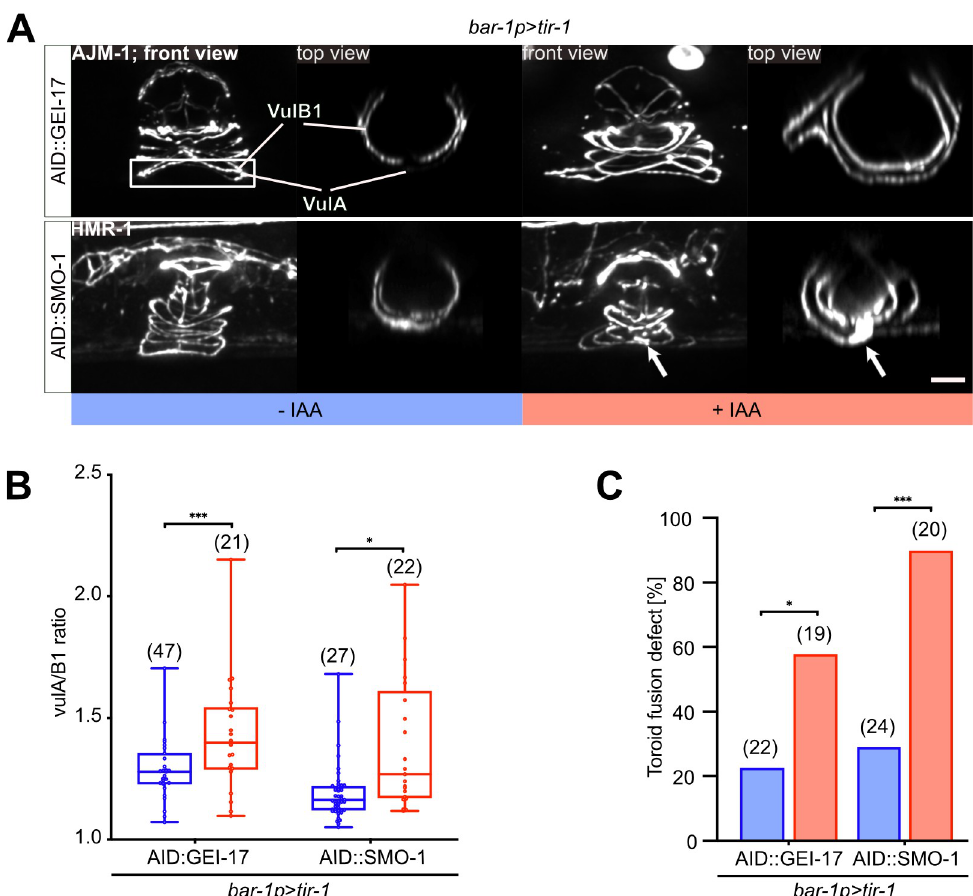
Fig 4. Inhibition of the SUMO pathway in the VPCs causes toroid morphogenesis defects. (A) Toroid morphogenesis defects in L4 hermaphrodites. 3D reconstructions of the adherens junctions labelled with AJM-1::GFP (for AID::GEI-17) or HMR-1::GFP (for AID::SMO-1) after VPC-specific degradation. Left panels show lateral views of z-projections. vulA and vulB1 toroids are outlined by the white rectangle in the top left panel and shown in top (xz) views in the right panels. White arrows point to abnormal fusion between the vulA and vulB1 toroids after AID::SMO-1 degradation. (B) Quantification of vulA contraction, calculated as the ratio of the vulA and vulB1 toroid diameter after VPC-specific AID:: GEI-17 or AID::SMO-1 degradation. The box plots show the median values with the 25 th and 75 th percentiles and the whiskers indicate the maximum and minimum values. (C) Penetrance of toroid fusion defects after VPC-specific AID:: GEI-17 or AID::SMO-1 degradation. In all experiments, untreated controls are labelled with–IAA (blue) and animals treated with 1 mM auxin +IAA (red). In each graph, the numbers of animals scored are indicated by the numbers in brackets. In (B) unpaired two-tailed t-tests and in (C) Mann-Whitney tests were used to determine statistical significance. p-values are indicated as � p � 0.05; �� p � 0.01; ��� p � 0.001. The scale bar is 5 μ m.